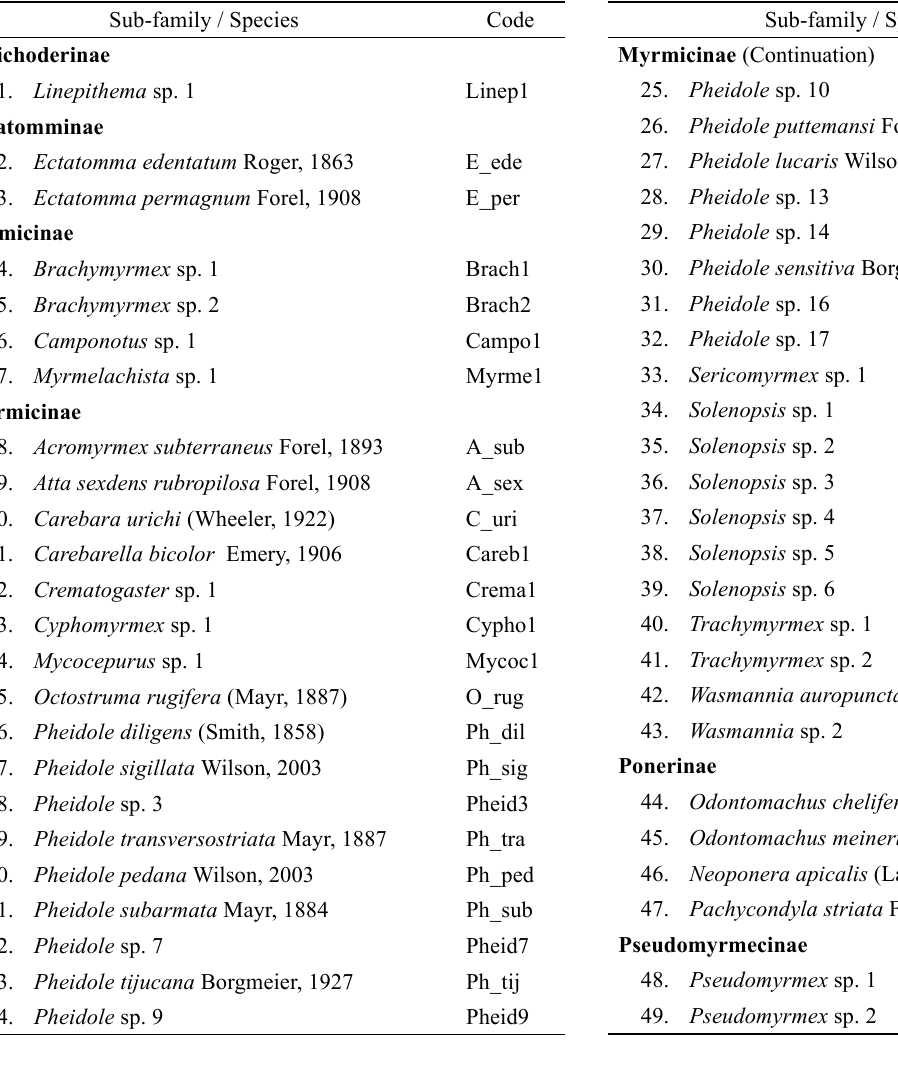
Table 2 . Ant species recorded in this study on Marambaia Island (RJ) interacting with diaspore